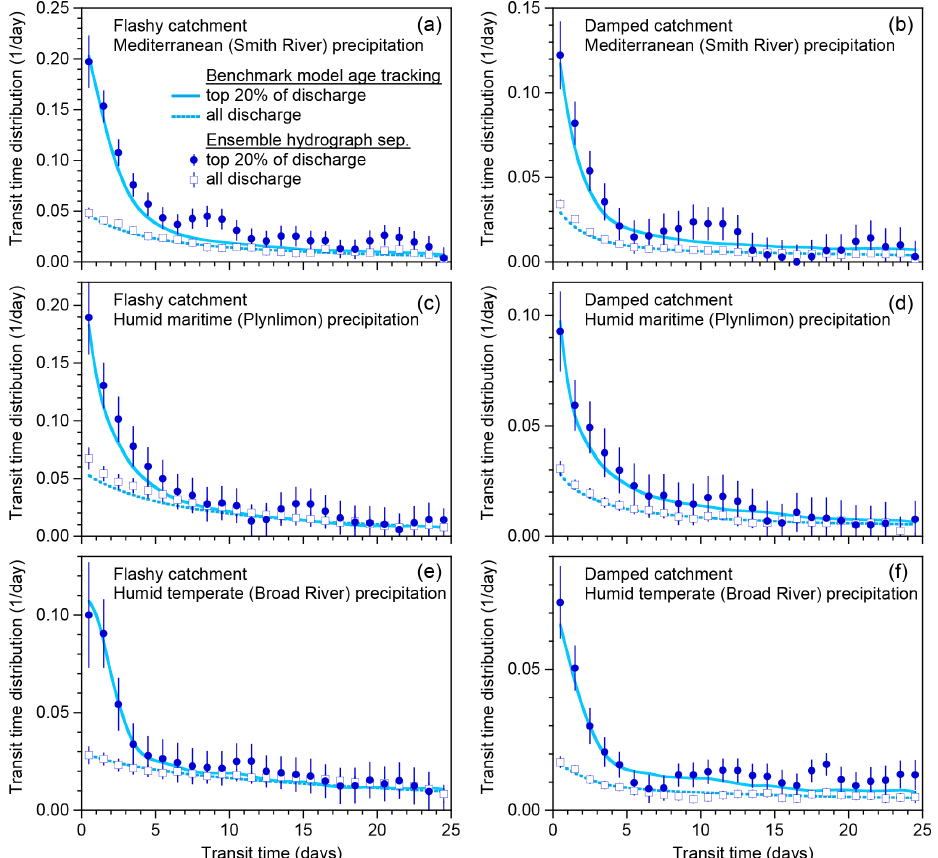
Figure 15. Transit time distributions Q TTD k for high flows (the highest 20% of daily discharges; solid curve and solid circles), compared to transit time distributions for all flows (dashed curve and open squares). Solid circles and open squares show Q TTD k estimates from ensemble hydrograph separation (Eq. 55); solid and dashed curves show true Q TTD k determined by age tracking in the benchmark model. Panels (a, c, e) and (b, d, f) show TTDs for flashy and damped catchments, respectively; the three rows of panels represent three different precipitation drivers. Note that vertical axis scales differ substantially. High flows have much larger contributions of recent precipitation than average flows do. Ensemble hydrograph separation quantitatively captures this behavior across flashy and damped model catchments with all three precipitation